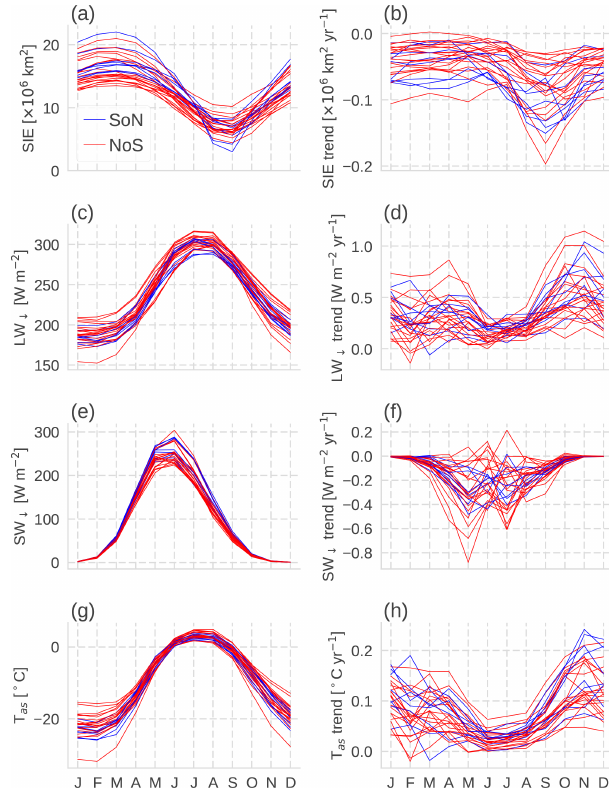
Figure 7. Output over 60–90 ◦ N oceans from individual CMIP5 historical-RCP8.5 simulations according to whether the simulation includes FIREs (blue) or excludes them (red). The left panels show annual cycles of mean properties from 1979 to 2005 and the right panels show the trend for each calendar month over 2006–2035. (a–b) Sea ice extent, (c–d) downward longwave radiation at the sur- face, (e–f) downward shortwave radiation at the surface and (g–h) near-surface air